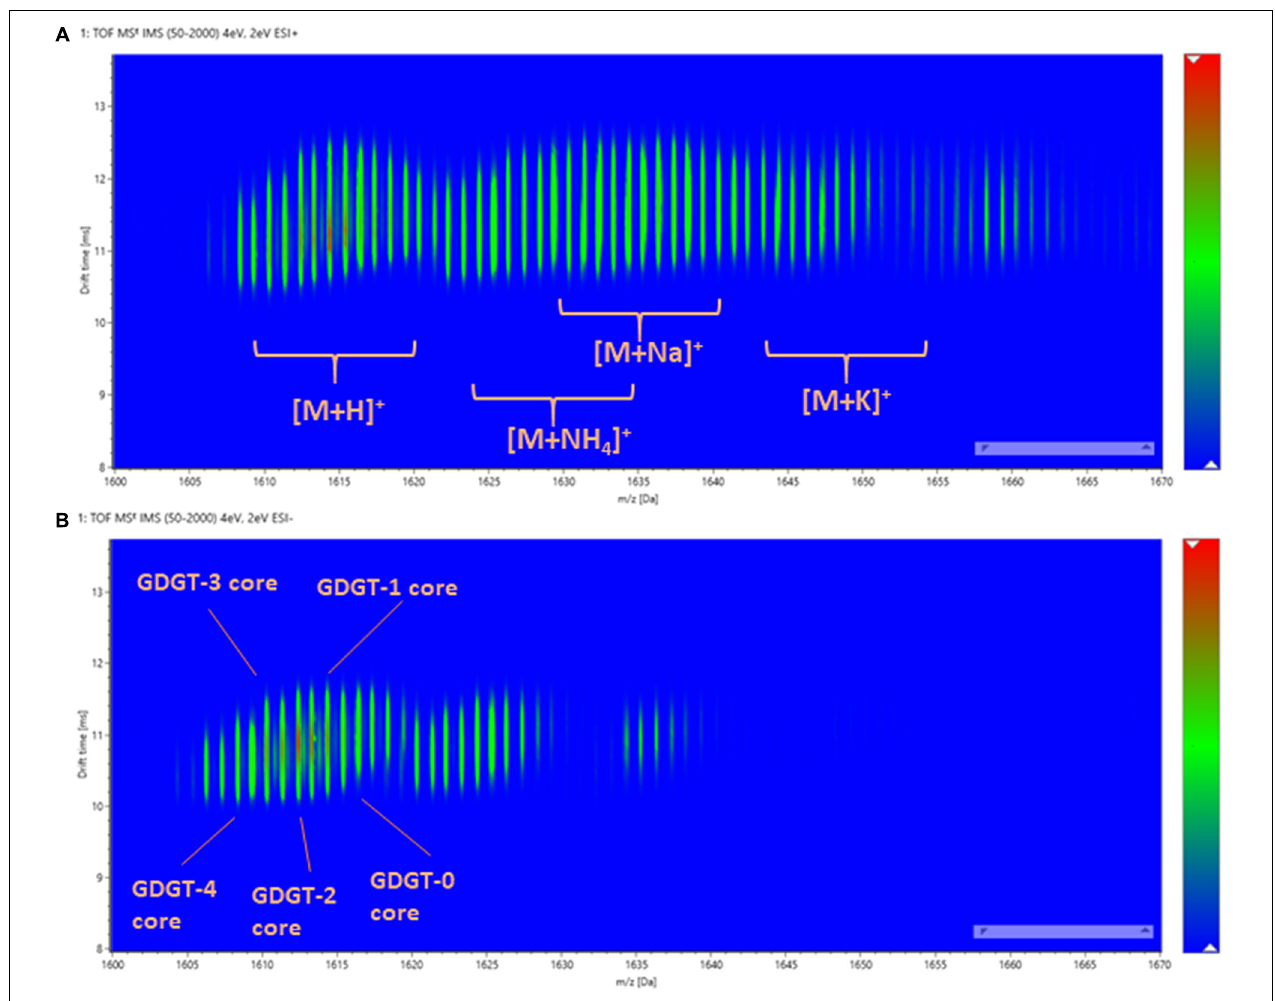
FIGURE 6 | The drift-time distribution of β -L-gulopyranosyl-caldarchaetidyl-glycerols measured in (A) positive and (B) negative ionization